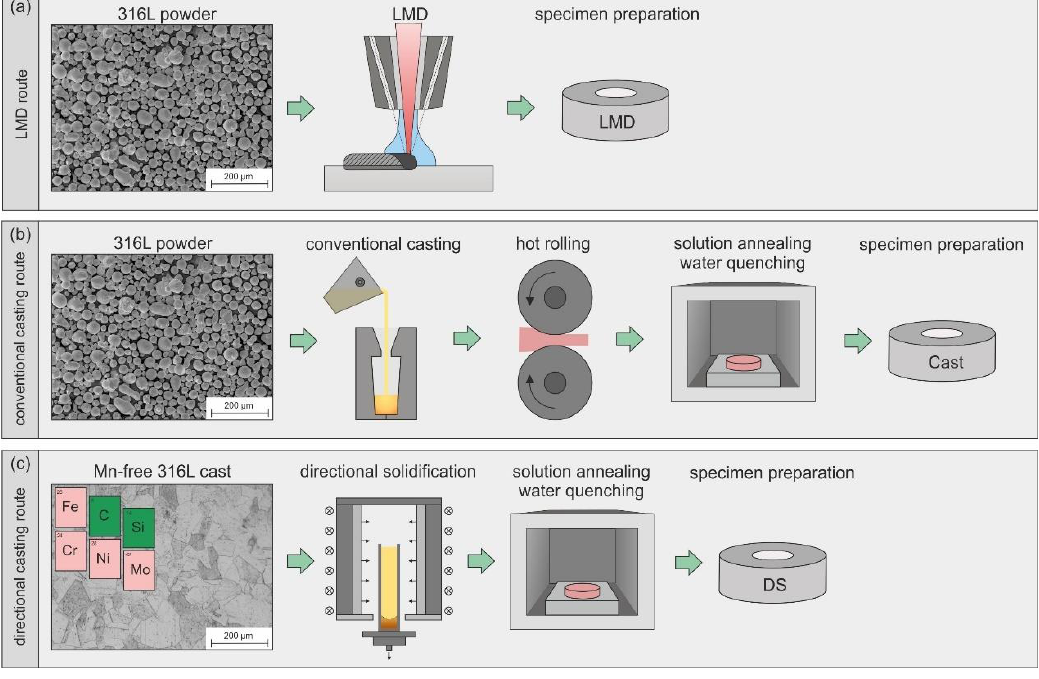
Table 1. Parameters of the laser metal deposition (LMD) process.